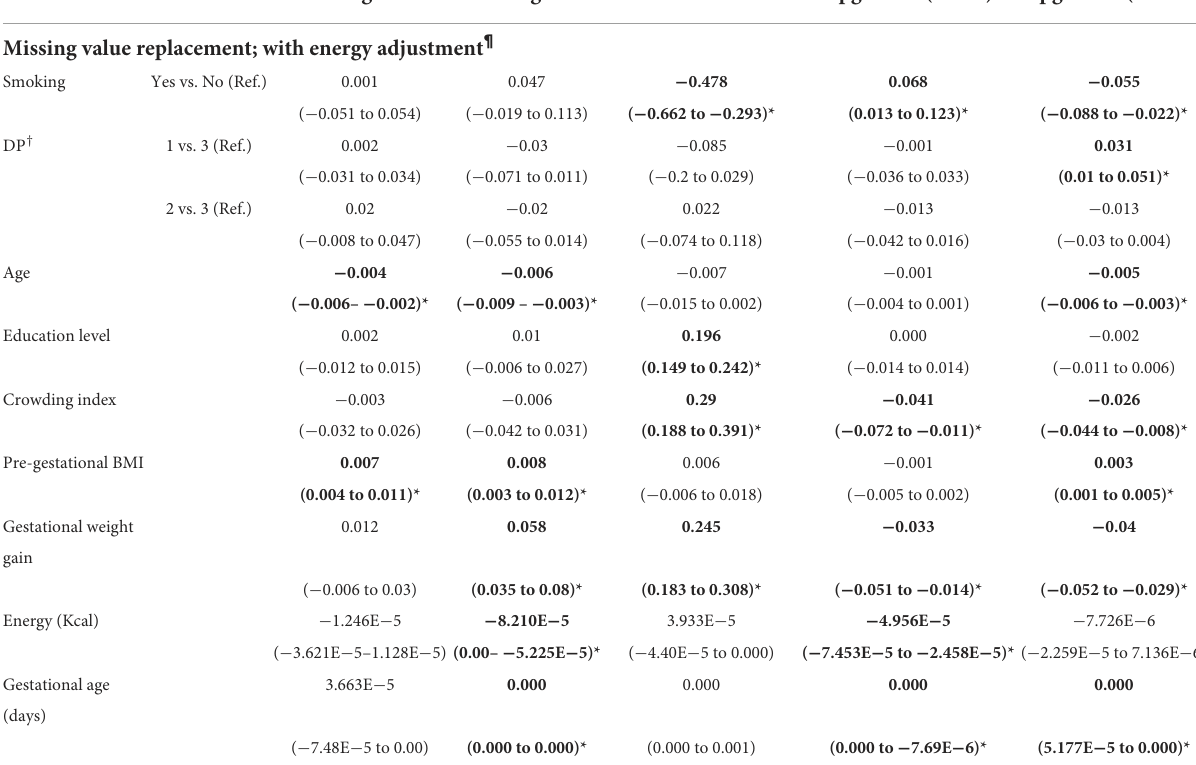
TABLE 11 Multivariate analysis of neonatal outcomes.